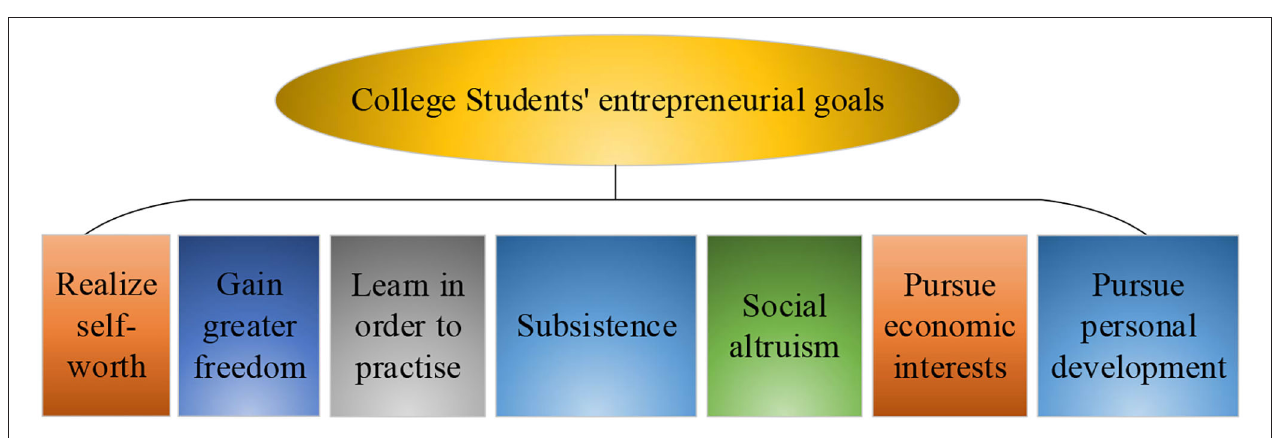
FIGURE 3 | Entrepreneurship goals of college